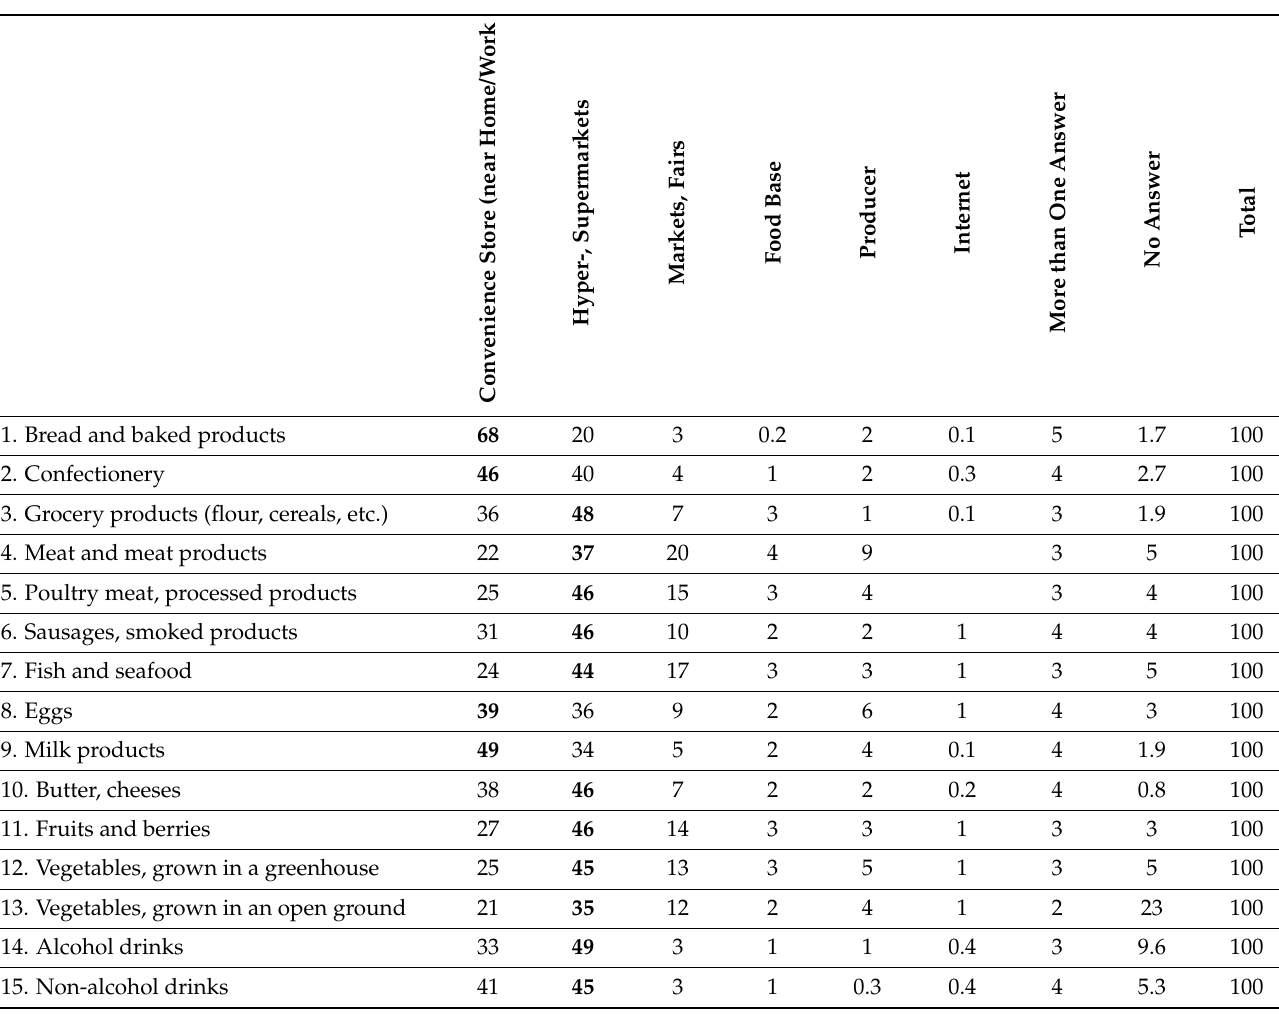
Table 3. Answers to question Q2. Where do you usually buy the following groups of products?—percentage of the